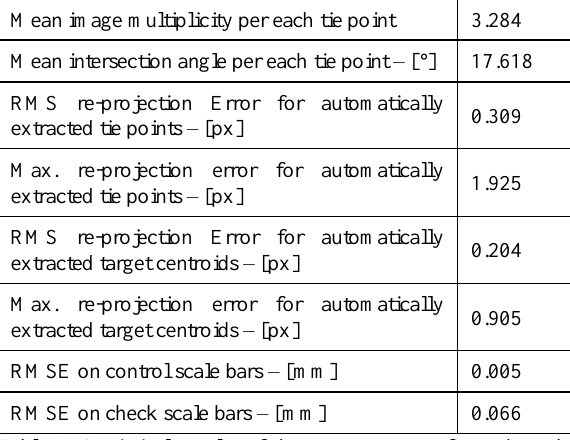
Table 2. Statistical results of the assessment performed on the reference image